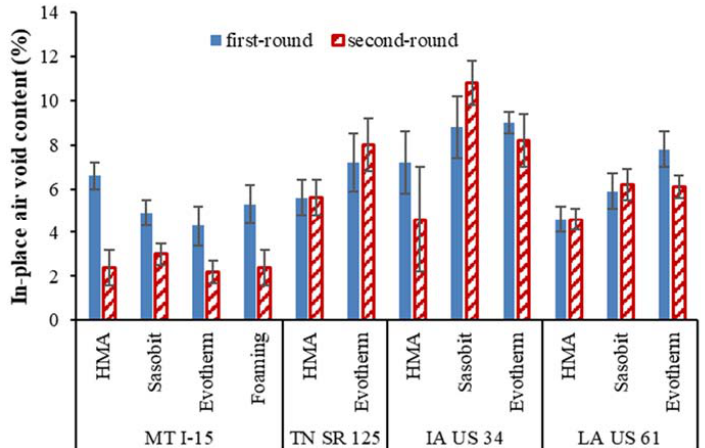
Figure 3. Comparison of in-place air voids.